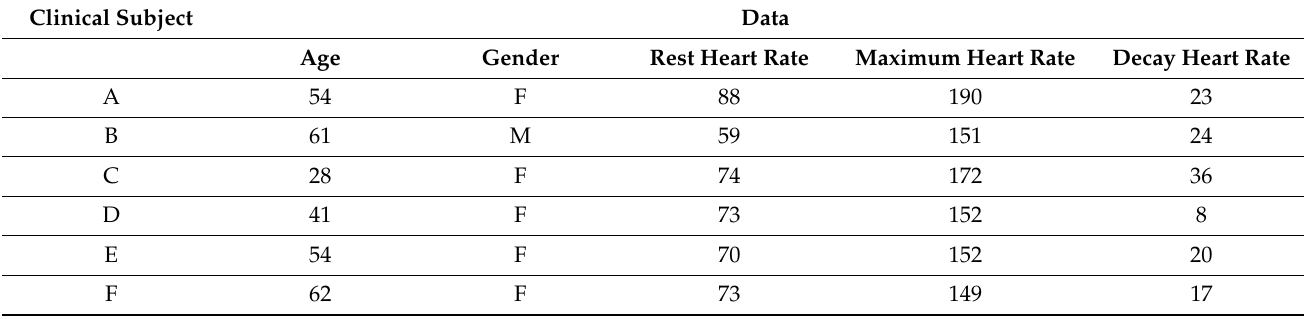
Table 1. Data of clinical subjects who participated in the experiment.